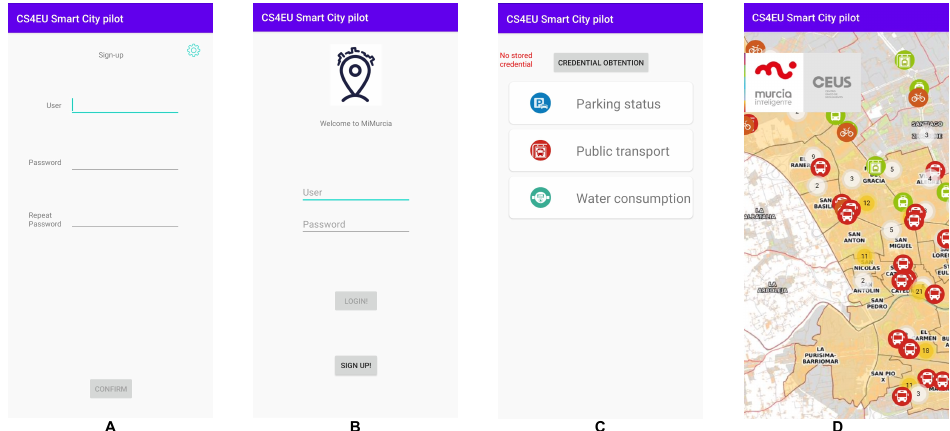
Figure 3. MiMurcia IoT Platform: proof of concept application